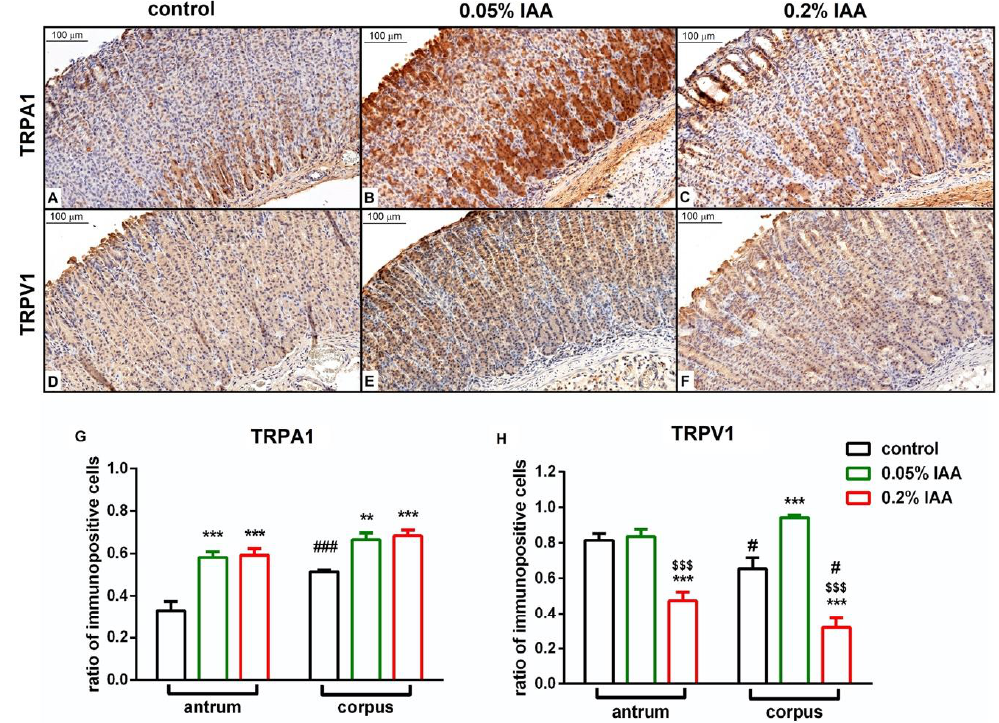
Figure 6. Quantitative analysis of TRPA1 and TRPV1 immunohistochemistry. Representative